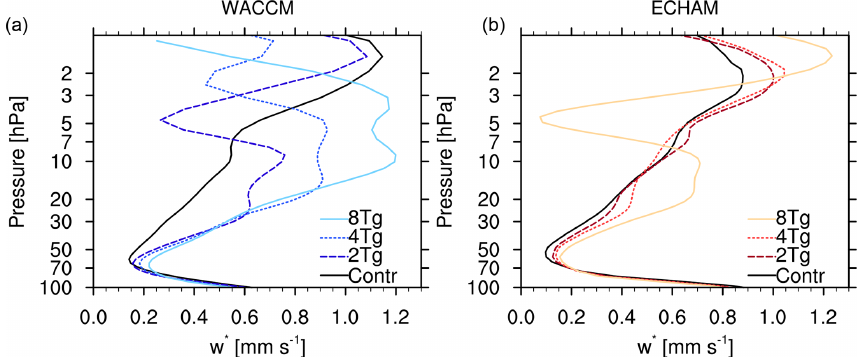
Figure 8. Residual vertical velocity in the tropics for the control simulation and simulations with injections of 2, 4 and 8Tg ( S ) yr − 1 for WACCM (a) and ECHAM (b)